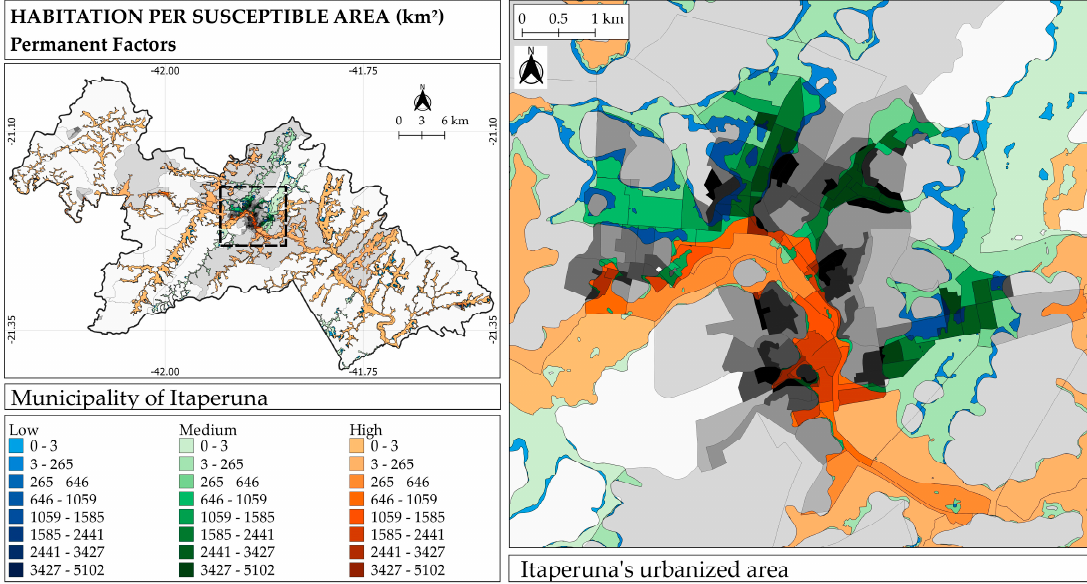
Figure 16. Flood susceptibility map of the municipality of Itaperuna categorized by low (shades of blue), medium (shades of green), and high (shades of red) susceptibility ratings, intersected by the census sector map of habitations per area released in 2010.